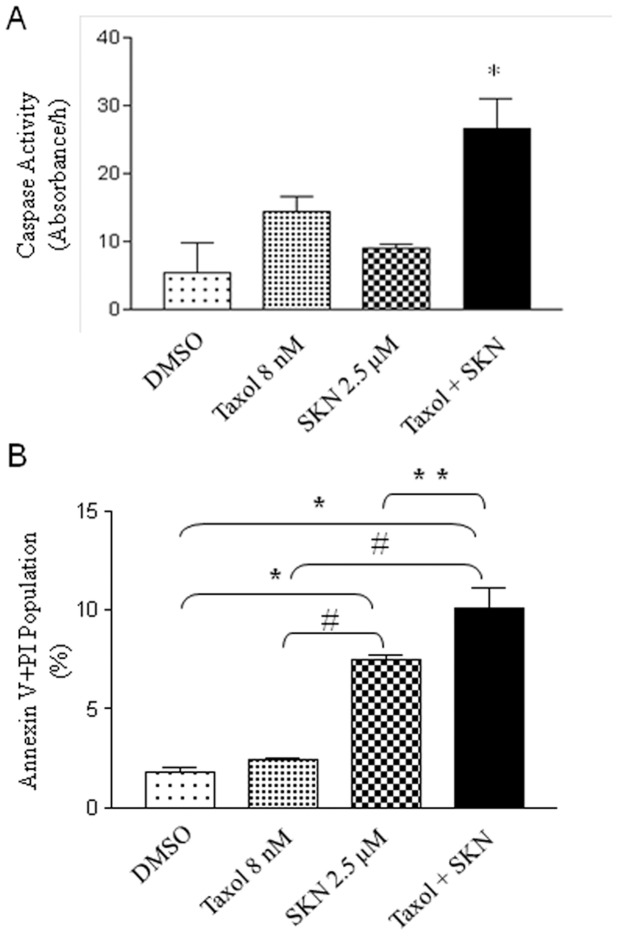
Apoptosis analysis of the combination treatment.Both caspase activity (A) and annexin V conjugates for apoptosis (B) were measured in MDA-MB-231 cells treated with DMSO as the vehicle control, taxol (8 nM), shikonin (2.5 μM), and the combination. Activity was measured as Δabsorbance after 1 hr incubation with the DTT assay buffer and the AFC-conjugated substrate (n = 3 in each group). * P<0.05 when compared to the control (DMSO), # P<0.05 when compared to the Taxol; ** P<0.05 when compared between SKN and Taxol+SKN.